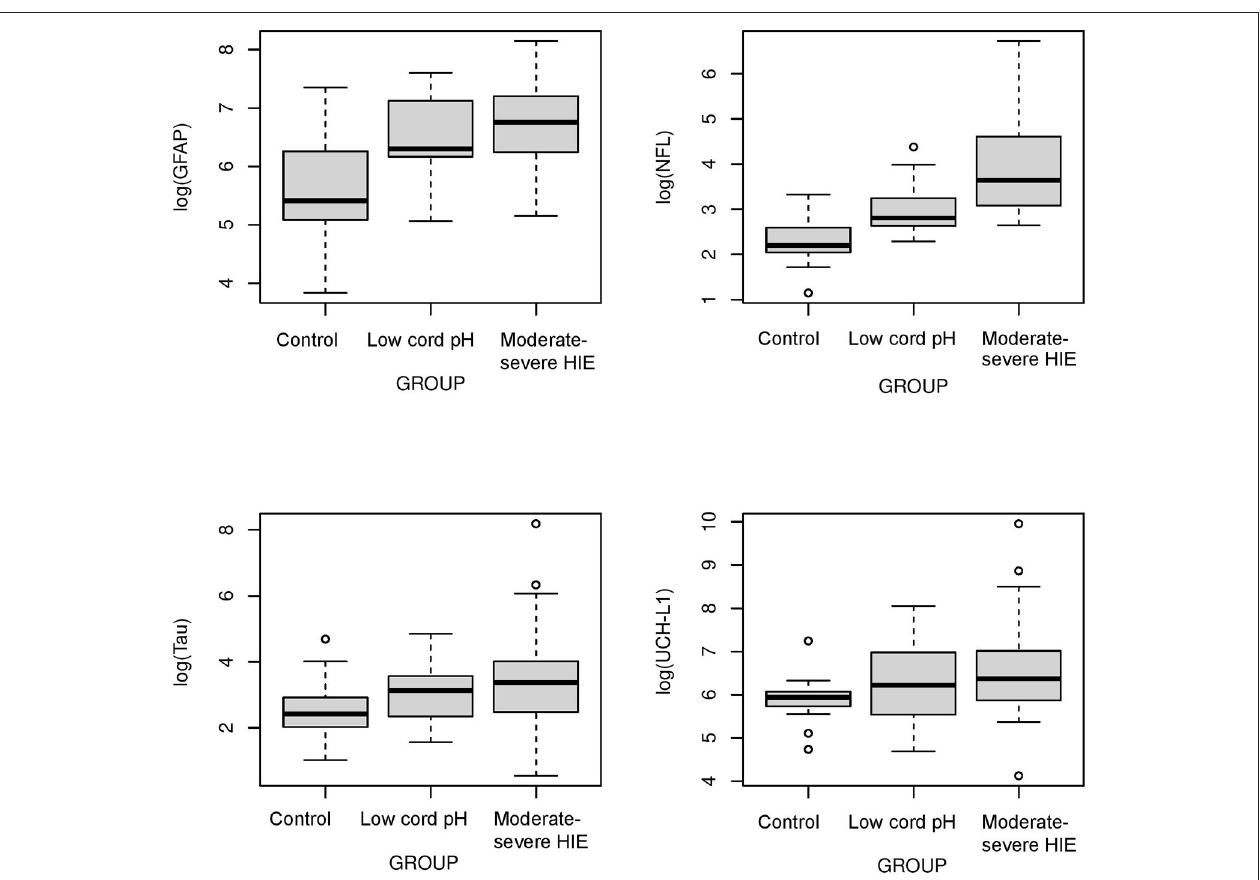
FIGURE 1 | Comparison of neuroprotein Biomarkers GFAP, NFL, Tau, UCHL-1 among Control, low cord pH neonates and moderate-severe HIE neonates. Compared to Control group, serum concentrations of GFAP, NFL and Tau were higher in low cord pH group ( P < 0.05) and moderate -severe HIE group ( P < 0.001). The concentrations of UCHL-1 were increased in neonates with moderate-severe HIE compared to control neonates ( P < 0.001). Concentrations of UCH-L1 was not different between controls and neonates with low cord pH, with/without mild HIE, at 0–6h of life. Compared to moderate-severe HIE, serum concentration of NFL was lower in mild HIE group ( P <